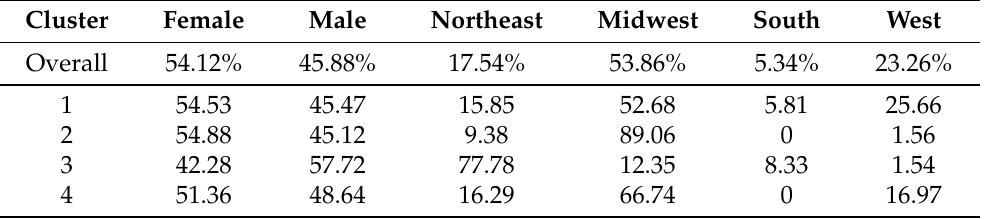
Table 7. Percentage of individuals who fall into sex and geographic categories for overall sample of 10,000 and for each of the four clusters. Given as percentages.